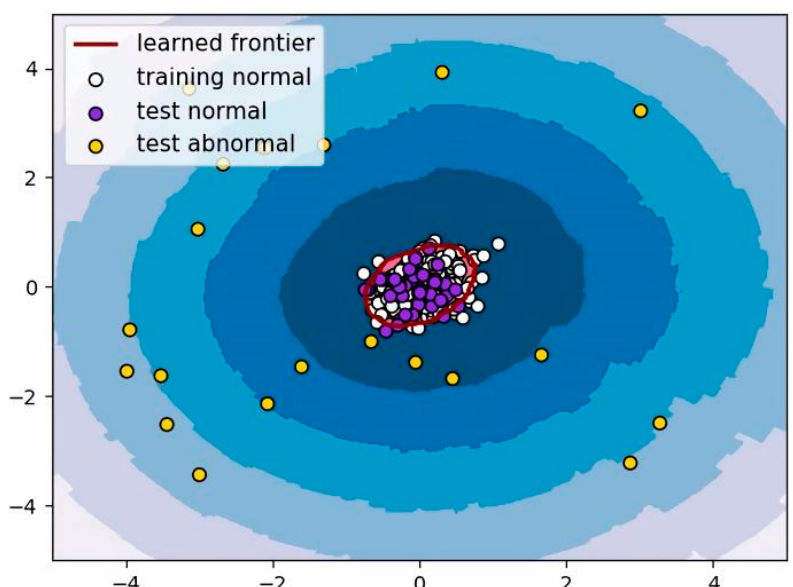
Figure 4. Schematic illustration of LOF. LOF can be used to determine the threshold of normal OCT images based on the local density of the normal images in the training set, and discriminate whether the test image is normal or abnormal (AMD).